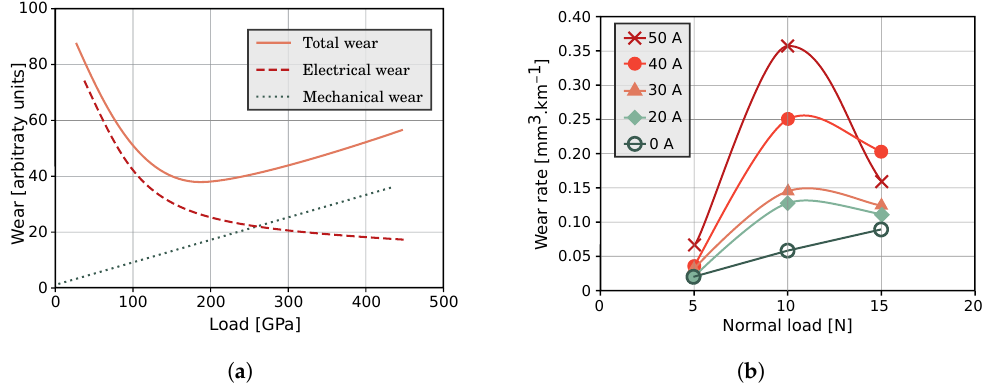
Figure 8. ( a ) Typical dependence of wear of electric machine brushes on load, from a book by Braunovic M. [60]. ( b ) Effect of load on the wear rate of the pin, from an article by Zhao H. et al.